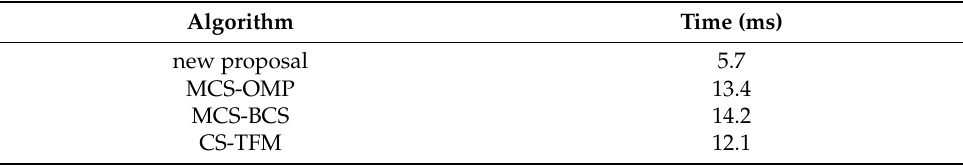
Table 3. Single frequency test signal calculation